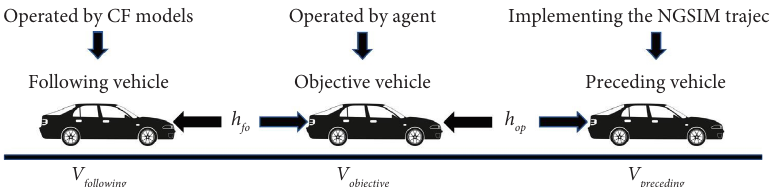
Figure 2: Redefned car following event in RL environment. h V denotes velocity of following following